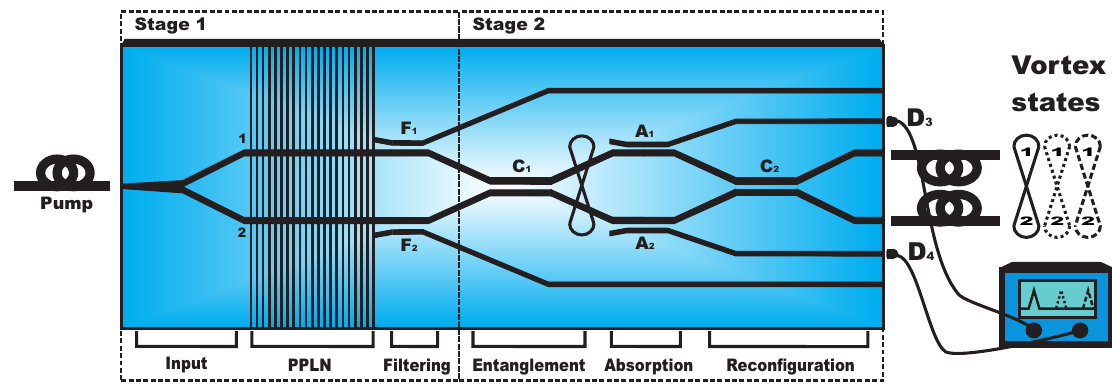
Figure 1. Sketch of the device proposed for producing CV quantum vortices. The first stage is devoted to the generation of the quantum state and pump supression. Two single-mode squeezed states (1 & 2) are produced in the periodically poled zone and the pump is filtered by means of wavelength-dependent DCs ( F 1 & F 2 ). The second stage is made up of an integrated Mach-Zehnder interferometer with two weakly coupled DCs in its arms. The two single-mode squeezed states are first mixed in a 3 dB DC ( C 1 ) in order to generate an entangled two-mode squeezed state. Next, the two weakly coupled DCs ( A 1 & A 2 ) leak photons to a pair of ancillary waveguides (3 & 4). Finally, the second 3 dB DC ( C 2 ) again mixes the states. The detection of n photons in the ancillary modes will herald a n -order quantum